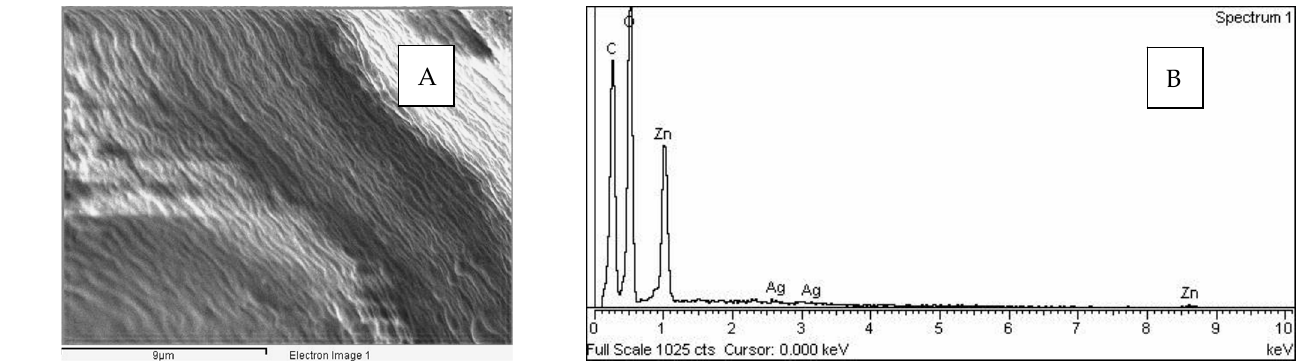
Figure 4. SEM-EDX chemical characterization: ( A ) the surface of the sample that was used for characterization; ( B ) SEM-EDX spectra showing the Ag in core and Zn in shell of antimicrobial microcapsules.